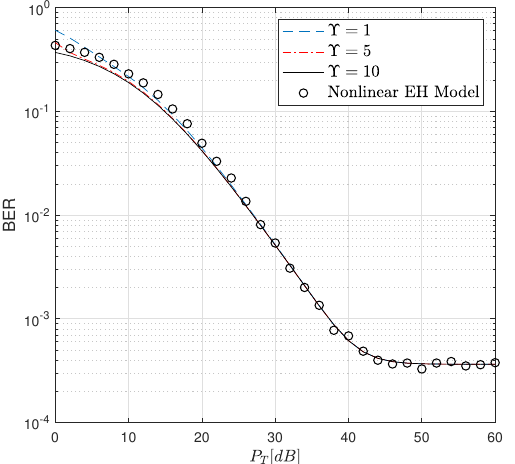
Figure 4. BER performance of the WP DH AF relaying system versus P T dB for P th = 35 dB. The BER performance of the proposed WP DH AF relaying system with respect to P T is presented in Figure 5. For P T values lower than 40 dB, the linear and non-linear models provide the same performance, while for P T higher than 40 dB, the BER performance for the non-linear EH model converges to the error floor, which verifies that the harvested power is higher than the threshold power. In other words, for higher SNR values, P s = P r = P th . It is seen from Figure 5 that the linear EH model overestimates the system performance compared to the realistic results obtained for the non-linear EH model. Moreover, consider- ing the linear EH model, approximately, 2 dB, and 6 dB SNR losses are obtained for the BER of 10 − 3 by increasing the value of d sd from 1 to 2 and 3,